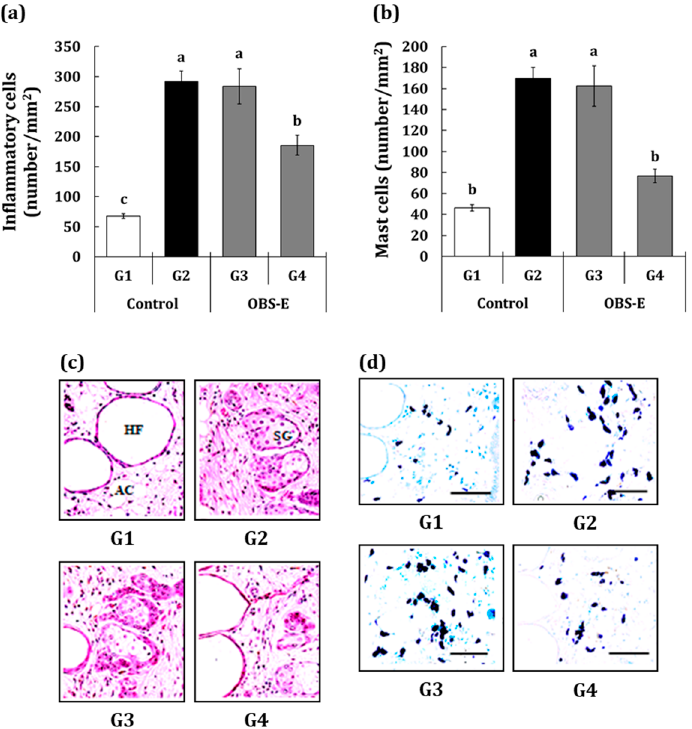
Figure 6. Effect of oral administration of OBS-E on the number of ( a ) inflammatory cells and ( b ) mast cells. ( c ) Skin biopsy samples stained with H&E for determining inflammatory cell counts, ( d ) skin biopsy samples stained with Toluidine blue for determining mast cell counts. HF, hair follicle; SC, sebaceous gland; Scale bars = 80 µ m. G1, non-irradiated control group administered saline; G2, UVB-irradiated control group administered saline; G3 and G4, UVB-irradiated test agent groups administered OBS-E at doses of 50 and 200 mg/kg BW/day, respectively. Different superscripts indicate significant difference among groups by Duncan’s multiple range test ( p < 0.05).